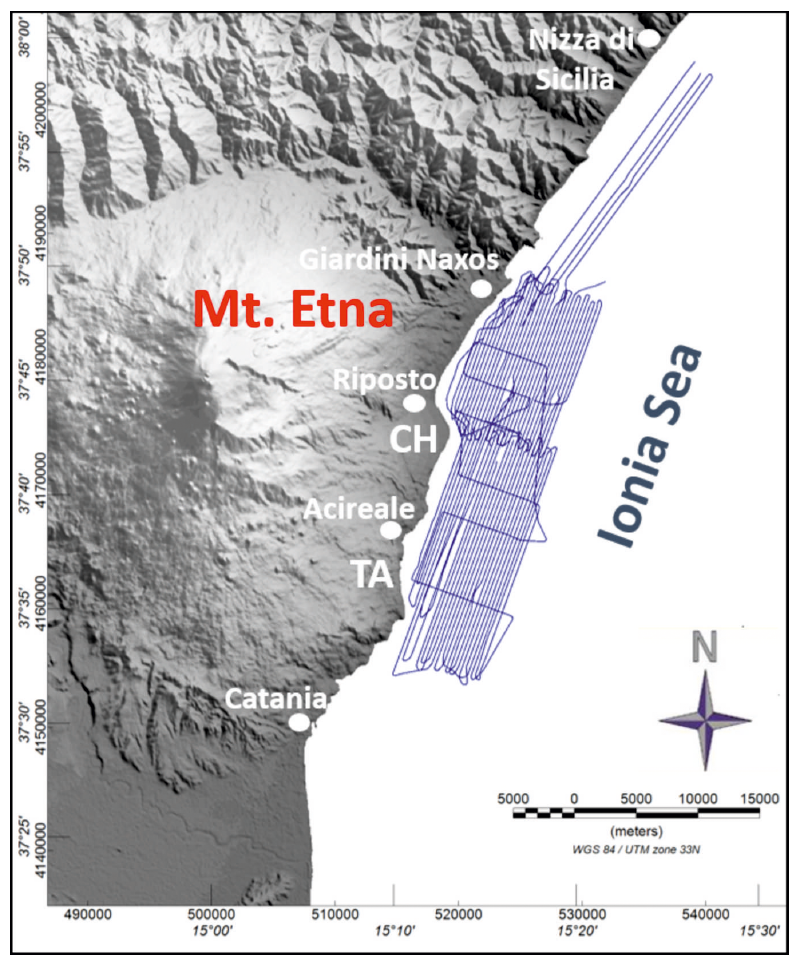
Figure 3. Track lines of the magnetic survey offshore Mt. Etna volcano. CH (Chiancone volcanoclastic deposit), TA: Timpa